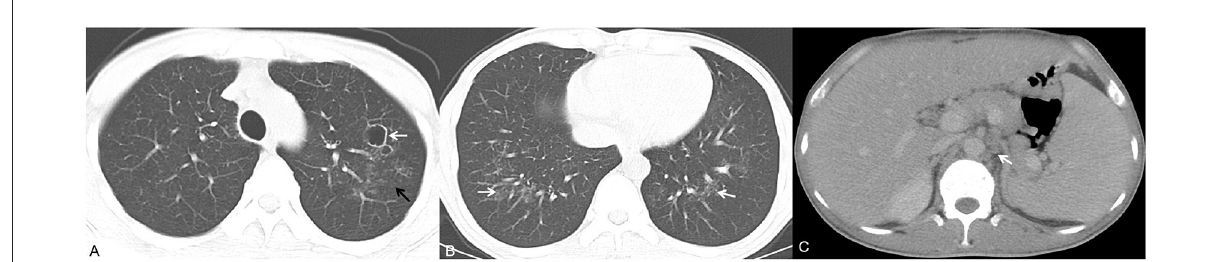
FIGURE3 A 40-year-old man presented with fever, cutaneous lesions and ulcers of the oral mucosa. Axial chest CT images (A,B) showed multiple cavities, multiple patches (white arrow) and small nodules (black arrow). Moreover, the patient exhibited homogeneous enhancement of hepatosplenomegaly and enlarged lymph nodes in the retroperitoneum [ (C) , white arrow].